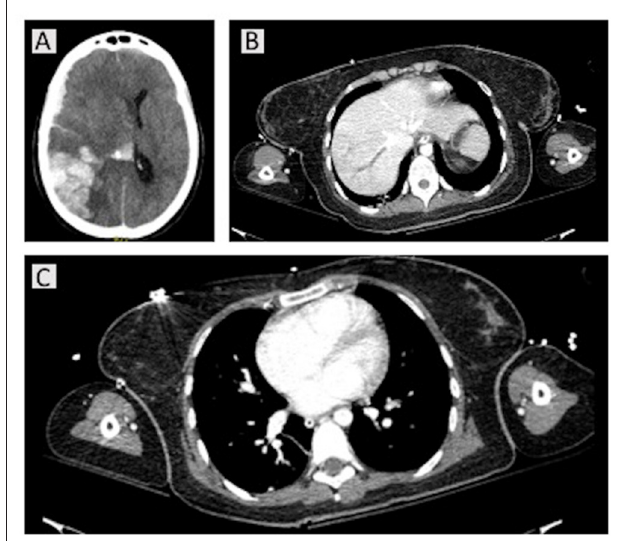
FIGURE 1 | Computed tomography (CT) scans for case 1. A non-contrast brain CT and angio-CT were immediately assessed on hospital admission, showing right temporo-parieto-occipital intraparenchymal hemorrhage with intraventricular hemorrhage, fronto-parietal subdural hematoma, with homolateral fronto-temporal subarachnoid hemorrhage. She presented with intracranial hypertension and a 15-mm midline shift, with uncal, transtentorial, and cerebellar herniations into foramen magnum (A) . The homolateral transverse and sigmoid sinuses were completely obliterated, as well as the jugular gulf; the sagittal superior sinus was partially obliterated. The intracranial arteries were obstructed. At thoracic CT perfusion and abdominal scans, pulmonary embolism in the arterial ramifications for the left inferior lobe and increased hepatic volume with thrombosis of the suprahepatic veins were present (B,C)